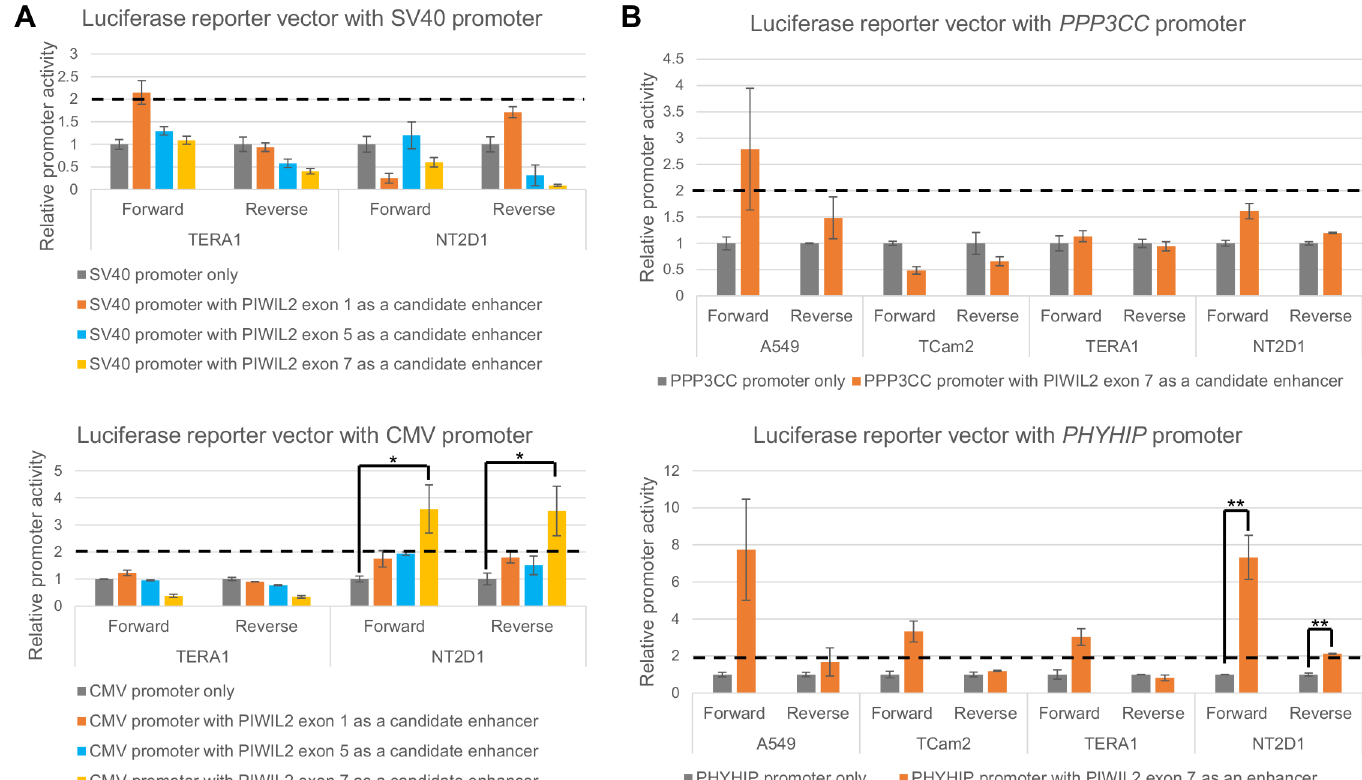
Fig 4. PIWIL2 alternative promoter in exon 7 acts as an enhancer in luciferase reporter constructs. Relative promoter activity of SV40 and CMV promoters was assessed in luciferase reporter vectors from Fig 3 in two cell lines: TERA1 and NT2D1 (embryonal carcinoma, panel A). PPP3CC and PHYHIP (panel B) promoters were assessed in luciferase reporter vectors from Fig 3 in four cell lines: TERA1 and NT2D1 – embryonal carcinoma, Tcam2 – seminoma, and A549 – lung carcinoma. P-value summary of Mann-Whitney non-paired U test is presented for peaks showing more than two-fold increase (above horizontal dashed lines) for both forward and reverse orientation of the candidate enhancer compared to “ no enhancer ” controls ( * — p-value < 0.05, ** — p-value < 0.01). doi:10.1371/journal.pone.0156454.g004 PLOS ONE | DOI:10.1371/journal.pone.0156454 June 1,